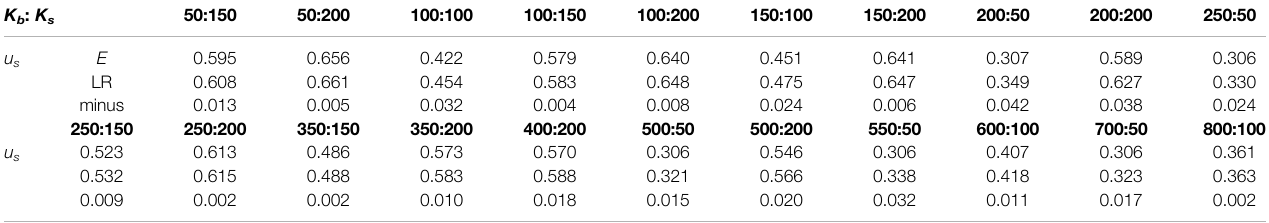
TABLE 1 | The equilibrium utility value when the blocker doesn ’ t selected Leader Rank and the maximum spreader ’ s utility value under the blocker ’ s Leader Rank branch in the decision tree. And their differences.